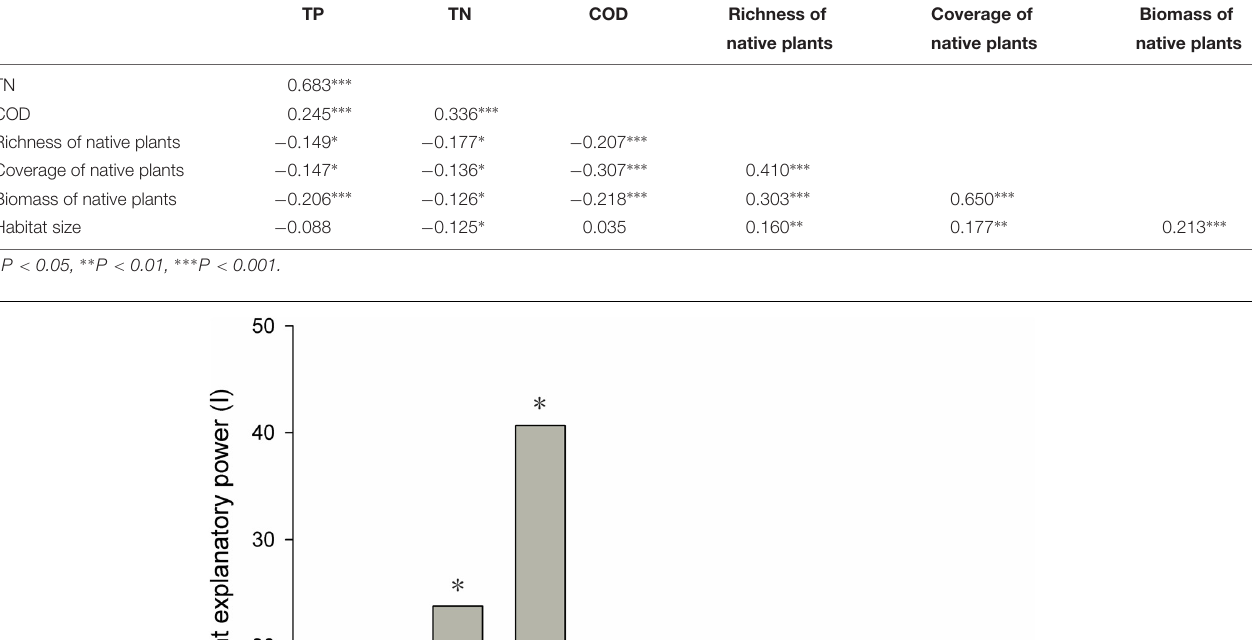
TABLE 1 | Correlation coefficients ( r -values) of simple regressions among TP, TN, COD, richness of native plants, coverage of native plants, biomass of native plants, and habitat size. TP